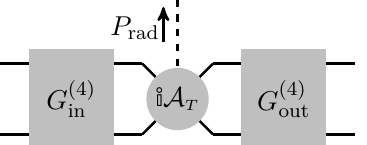
Figure 4 . Radiative bound-state formation and bound-to-bound